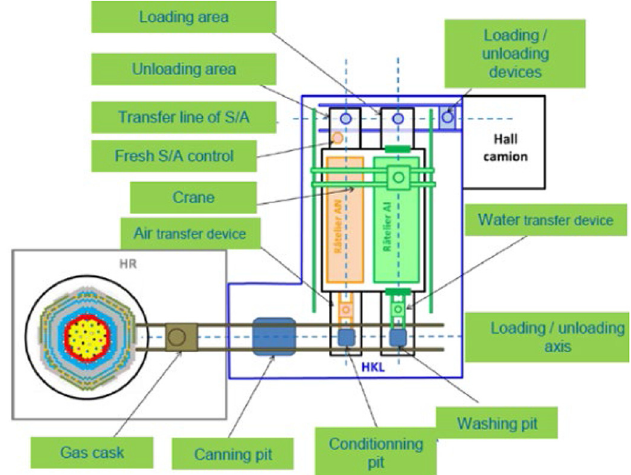
Fig. 11. FHS in ASTRID 150.